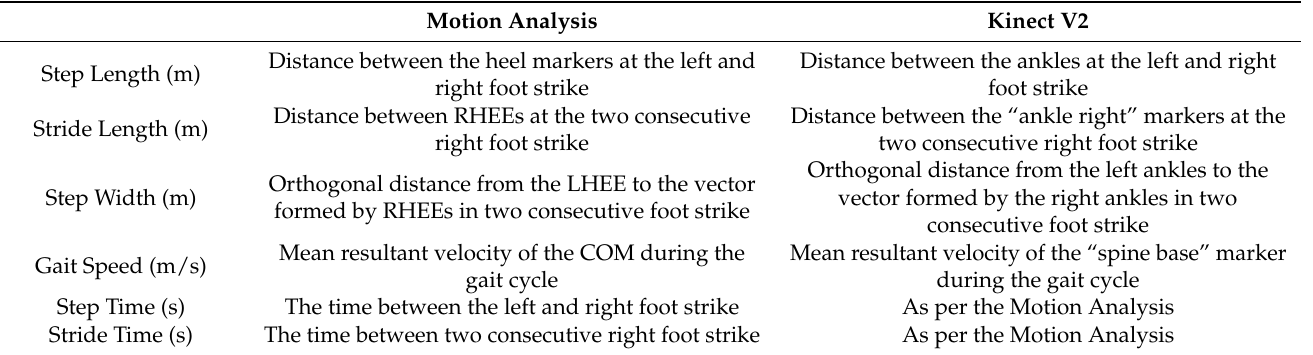
Table 1. Definitions of spatiotemporal gait parameters in the Kinect V2 and Motion Analysis system [35,45,46].